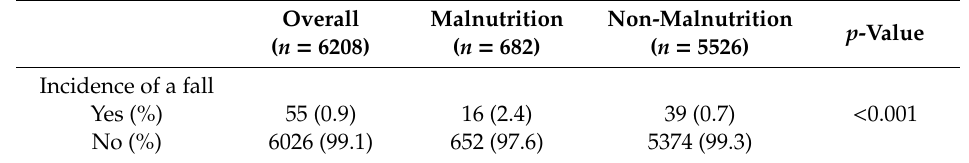
Table 2. Outcomes during hospitalization.